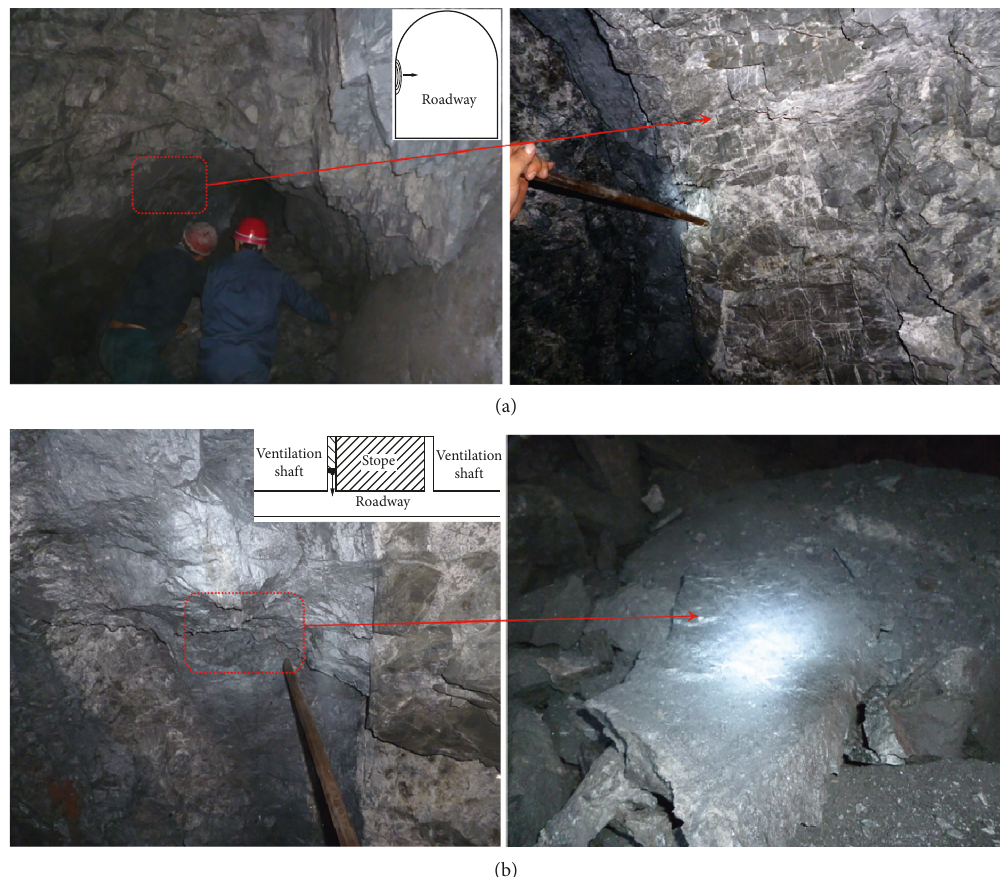
Figure 3: Typical rockbursts. (a) A spalling rockburst in a transport roadway at − 115m level. (b) A strong rockburst in a ventilation shaft at − 160m